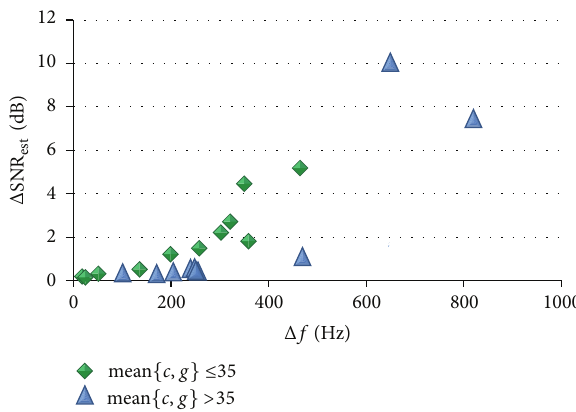
Figure 8: Difference in SNR values for BER equal to 2 ⋅ ) asafunctionofthespectralwidth Δ𝑓 andmean {𝑐, 𝑔} . 10 −4 (Δ SNR est